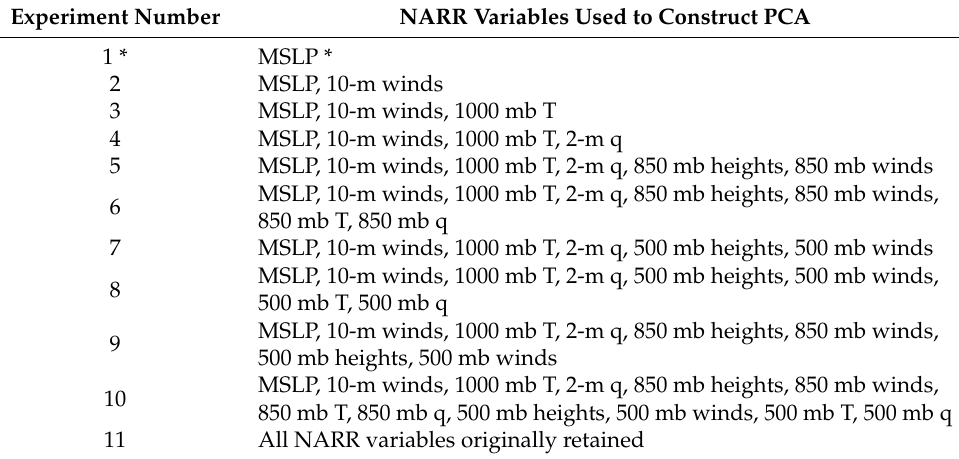
Figure 3. Histogram of longitude locations of LES-associated clippers during the start of LES formation. These values are associated with 41 LES events from the Mercer and Wiley (2020) and Wiley and Mercer (2021) LES repository. Note the bimodal distribution featuring a high frequency of longitudes around 75 ◦ W (mode longitude) and 90 ◦ W. These two locations mark the positions of clippers that resulted in LES across the eastern (Lakes Erie and Ontario) and western (Lakes Michigan and Superior) Great Lakes, respectively. Table 2. Various NARR configurations tested to evaluate the optimal fields to retain for the PCA and CA. Starred fields represent the configuration used for the statistical